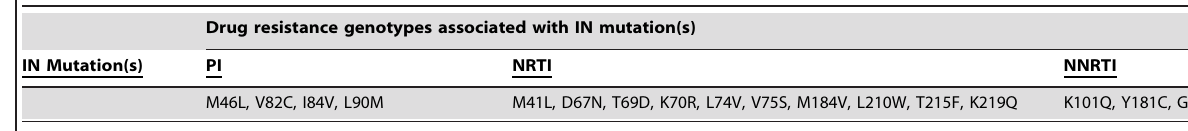
RAL treatment [16], changes in DRM patterns or pathways over